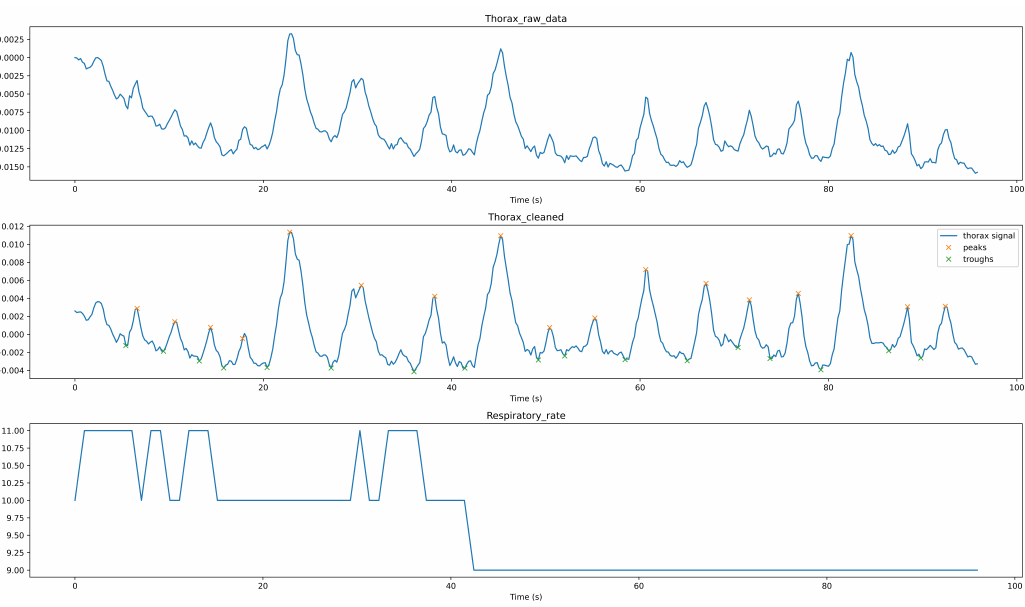
Figure 8. Breathing analysis for a professional meditator.